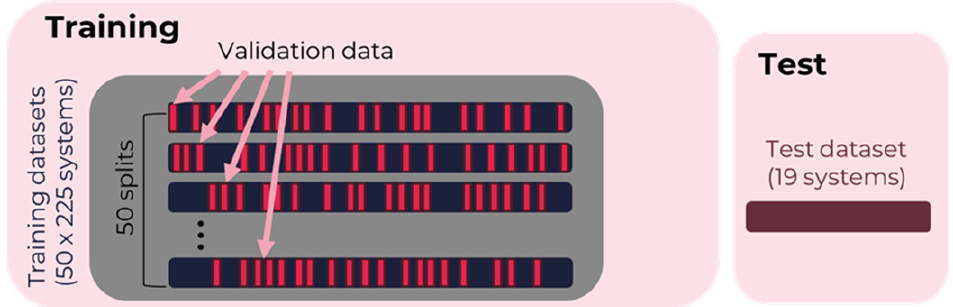
Figure 1. Split of training data with 50-fold cross-validation and additional test data. The selection of the validation data is performed randomly each time.